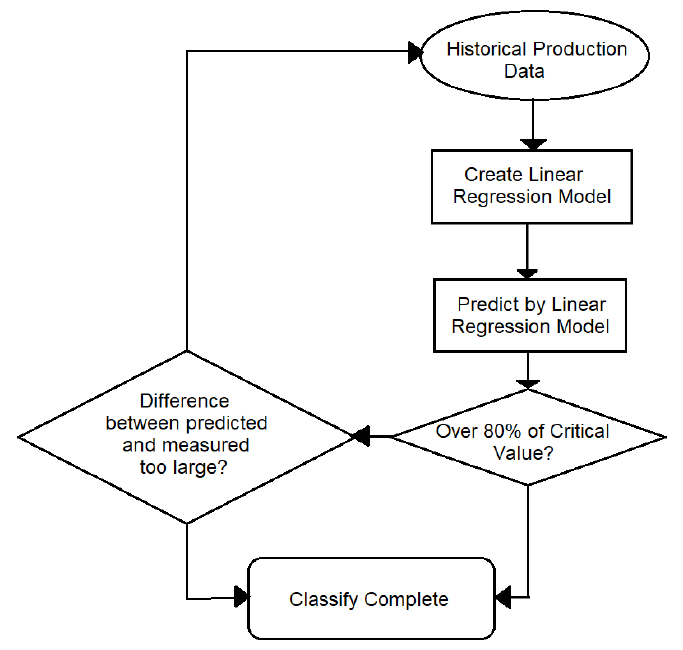
Figure 5. Machine status analysis flow chart.